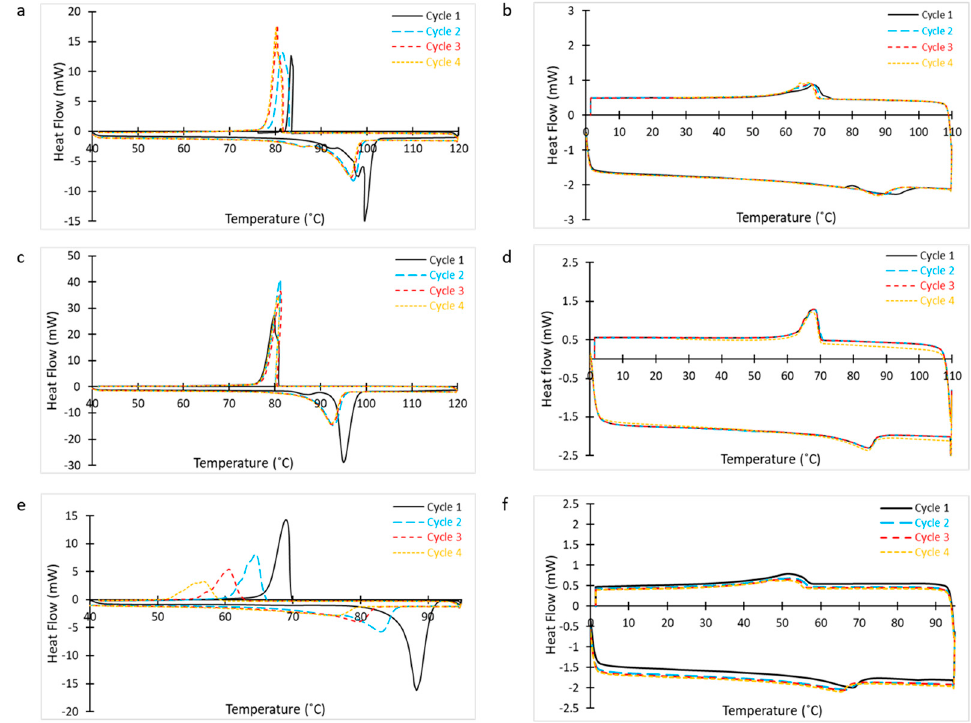
Figure 2. DSC thermograms: ( a ) neat DIBA; ( b ) 3 wt% DIBA-silicone oil gel; ( c ) neat DIPA; ( d ) 3 wt% DIPA-silicone oil gel; ( e ) neat DMEA; ( f ) 3 wt% DMEA-silicone oil gel. The measurements were repeated four times on one sample aliquot. Both heating (negative heat flows) and cooling (positive heat flows) cycles are shown.